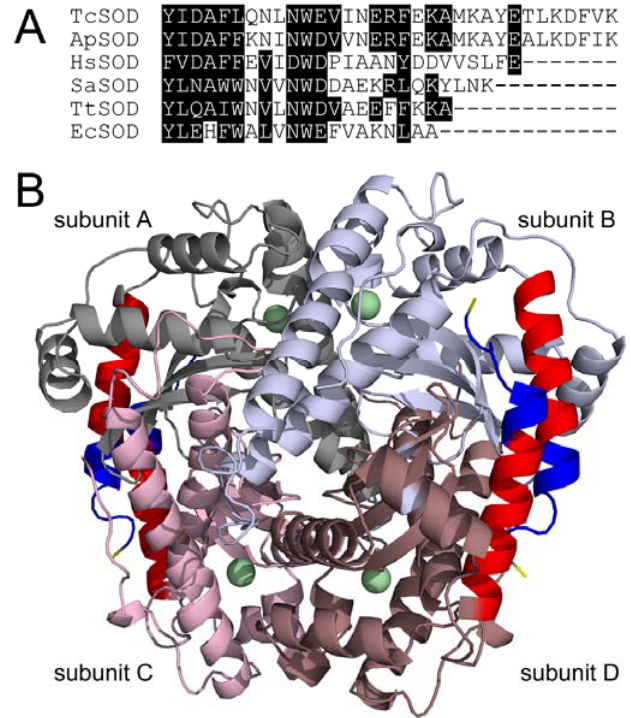
Figure 1. (A) Sequence alignment of the C- terminus of hyperthermophilic (TcSOD and Ap SOD) and thermophilic/mesophilic (HsSOD, SaSOD and TtSOD) SODs. Ap SOD, A. pyrophilus SOD; Hs SOD, H. salinarum SOD; Sa SOD, S. acidocaldarius SOD; Tt SOD, T. thermophilus SOD; Ec SOD, E. coli Fe-SOD. The residues with high homology were highlighted by black background. (B) Crystal structure of Ap SOD (PDB ID 1COJ). The four subunits were drawn in different colors, and the C- terminal helix was presented in red. The last two turns of the C- terminal helix (residues from 202 to 210) were highlighted